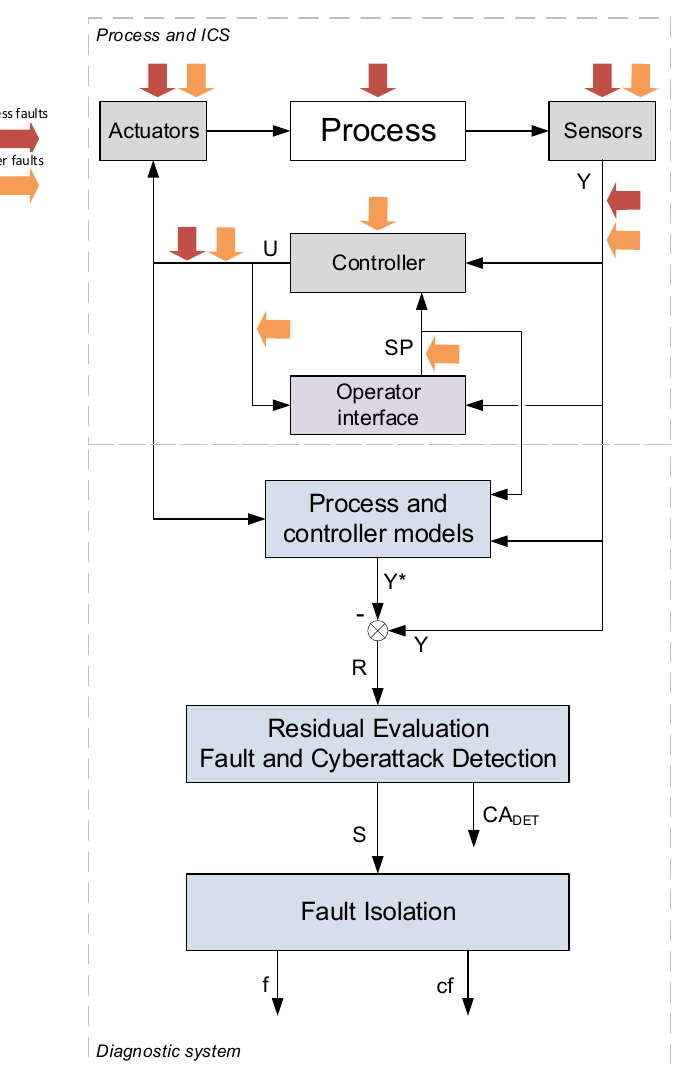
Figure 1. Faults and cyber-attacks and their influences on industrial systems.